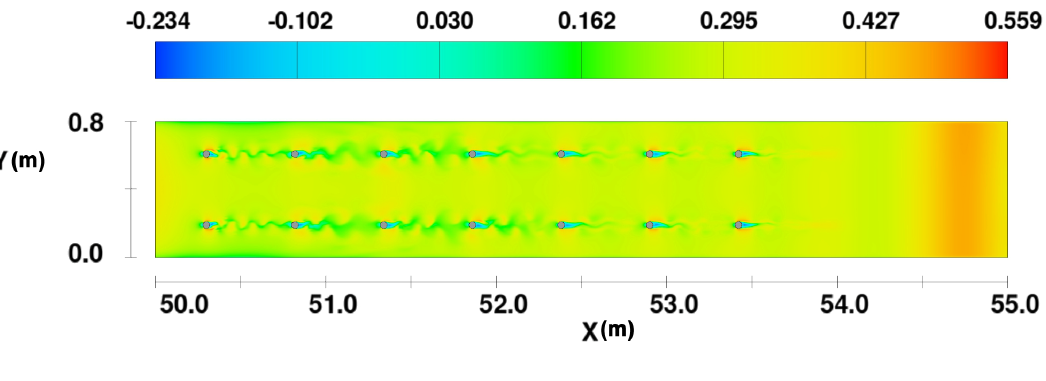
Figure 8. of excess shear stress on the riverbed (z = 0.002 m, t = 50 s) (unit: Pa). 212 3.1.2. The X-Velocity Field Around Two Columns of Tandem Piers of the Longitudinal Bridge 213 Seven pairs of tandem piers with a span of 0.52 m were built based on the layout and boundary conditions in the river model shown in Figure 5. The same parameter setups were used here. The x-velocity of the riverbed surface (z = 0.002 m) at di ff erent times were analyzed in Figure 9a–c. The riverbed was analyzed because the erosion, scour, and siltation occurred at the riverbed, which is critical to the local scour of bridge piers.